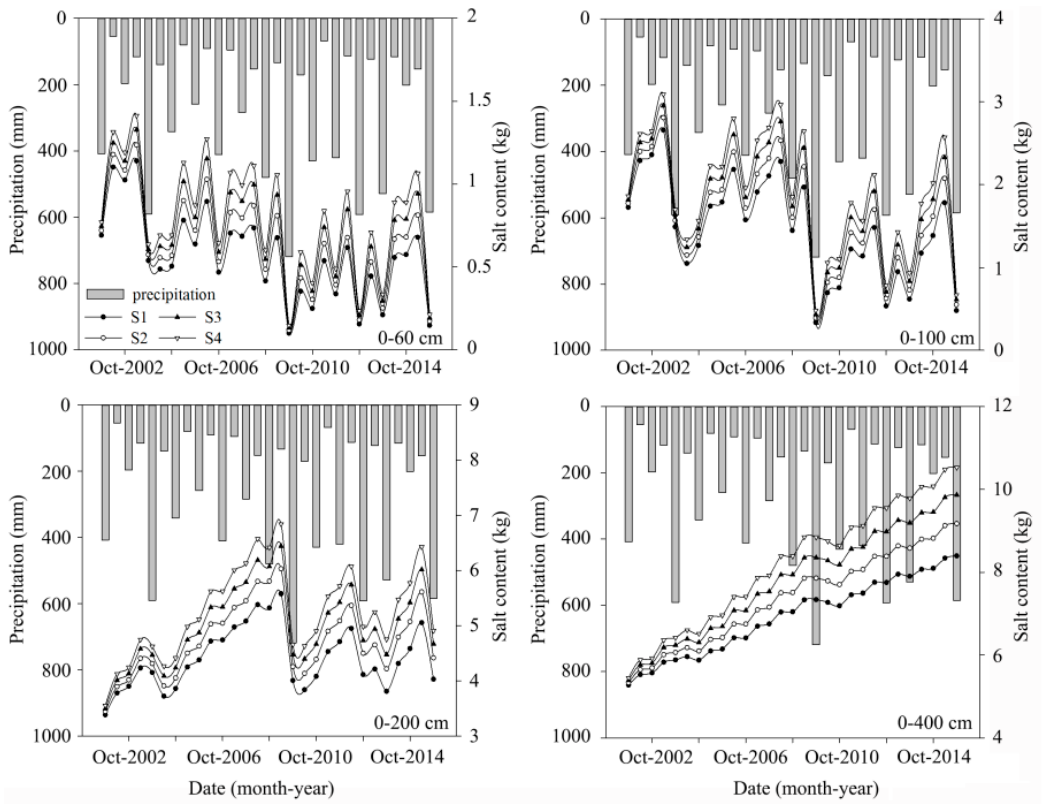
Figure 7. Dynamics of precipitation during the crop growing season under 15 years of brackish water irrigation and the salt content in the 0–60-cm, 0–100-cm, 0–200-cm and 0–400-cm soil layers at wheat and maize harvests.